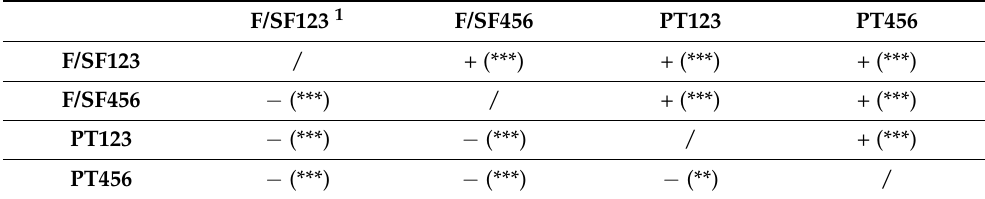
Table 15. The comparison of player levels’ influence on pacing strategy between Q3 and Q4. F/SF123